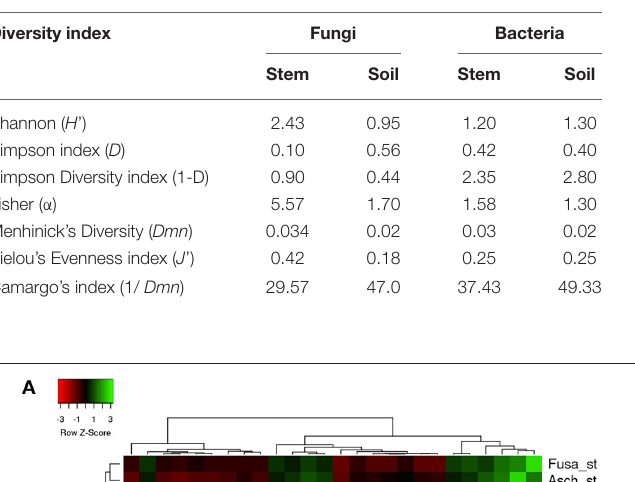
TABLE 2 | Diversity indexes of fungi and bacteria in the different samples.